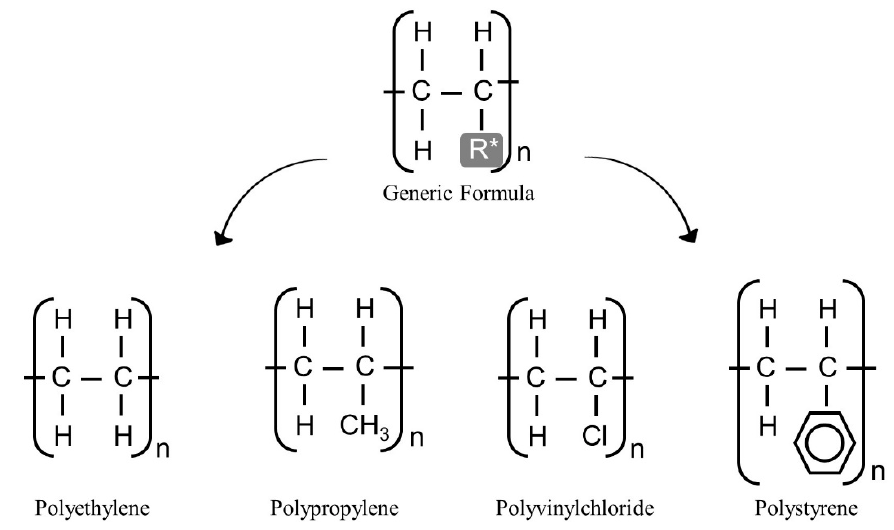
Figure 2. Representation of polymers that share the same generic formula. R*: Free radical.